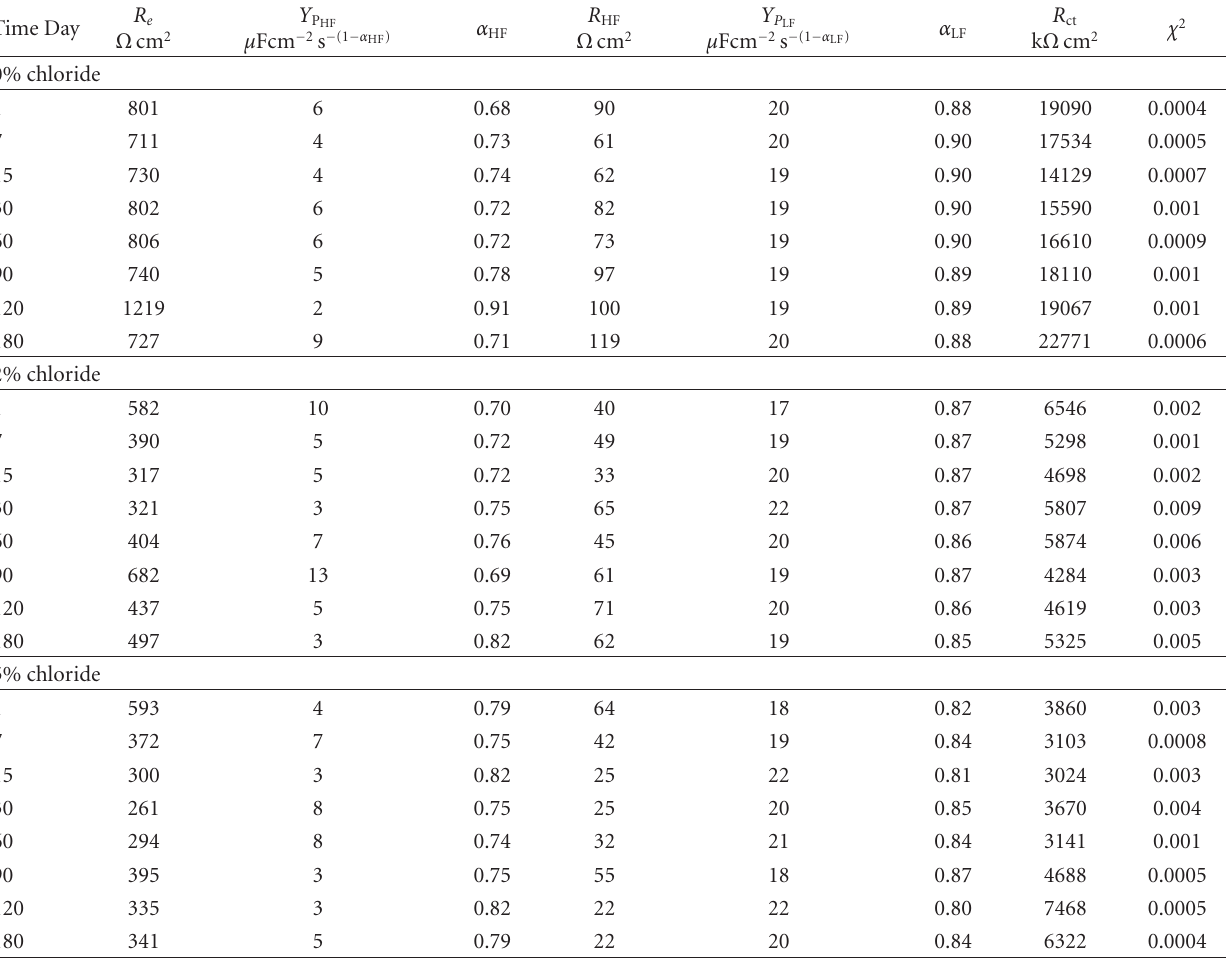
Table 5: Parameters used in the fitting of impedance data for low-nickel SS rebar embedded in B mortar. Time Day